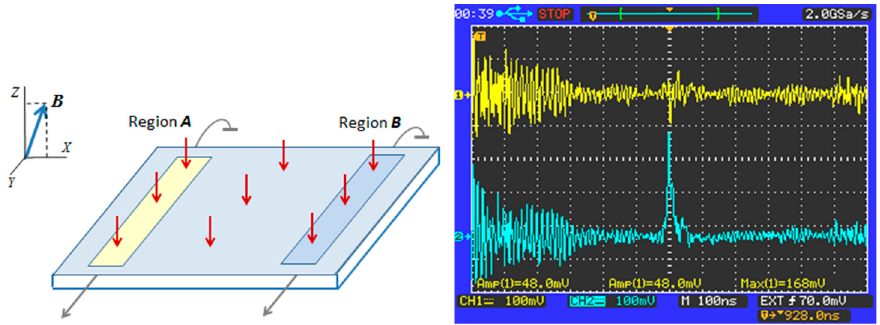
Figure 5. Observation of light-induced electron dynamics with a macroscopic spatial discontinuity. ( Left-hand panel ) Sketch of the test. Conditions are the same as in Figure 3a but now there are only two contact pairs and the sample is covered by a non-transparent plate with two windows: in the region A (formerly pair No. 1) as well as in the region B (formerly pair No. 4). Responses are measured in both regions. In the figure, only the window A is open. ( Right-hand panel ) Typical tracks when only the window A is open ( B = 5 T): upper track–response from the illuminated region A ; lower track–response from the distant (from the laser spot) region B . Both responses are equally pre-amplified. Timescale is 100 ns/div.